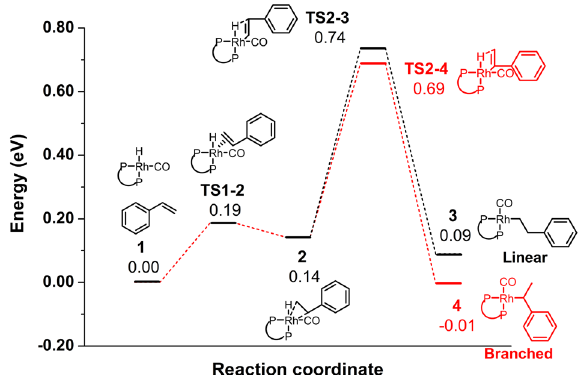
Fig. 6 Free energy pro fi les of the branched, and linear reaction pathways for styrene hydroformylation. All of the calculations were performed with Gaussian09 package (see Supplementary Information for detail). Geometry optimization of all the minima was carried out at the B3LYP level with the 6 – 31 G* basis set for C, H, N, O, P and Lanl2DZ for Rh. Default convergence criteria were used.